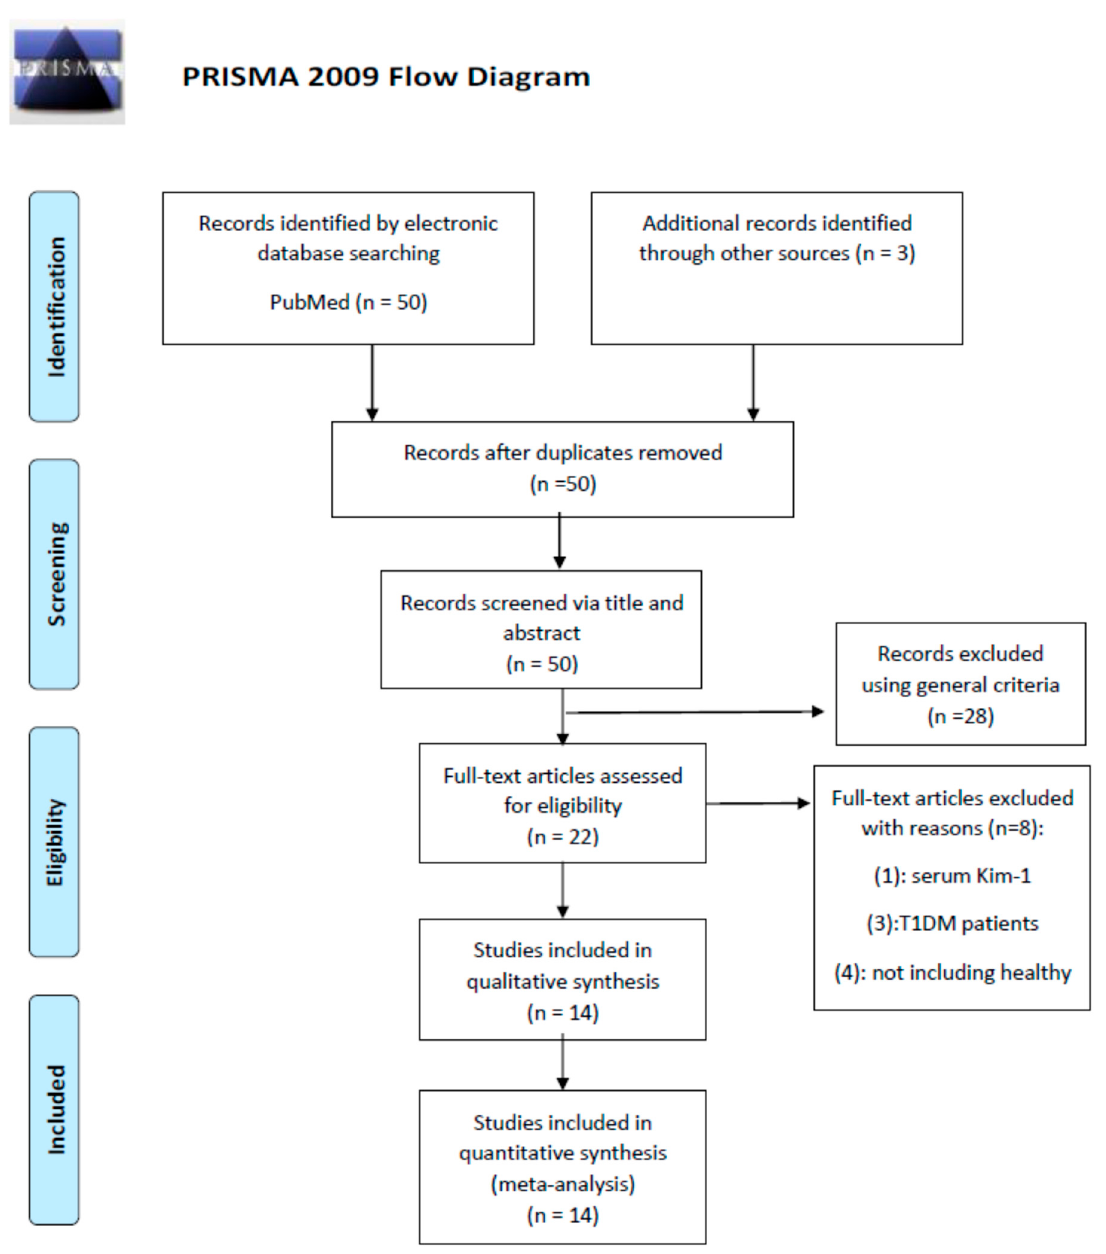
Figure 1. The PRISMA flow diagram for the included studies.